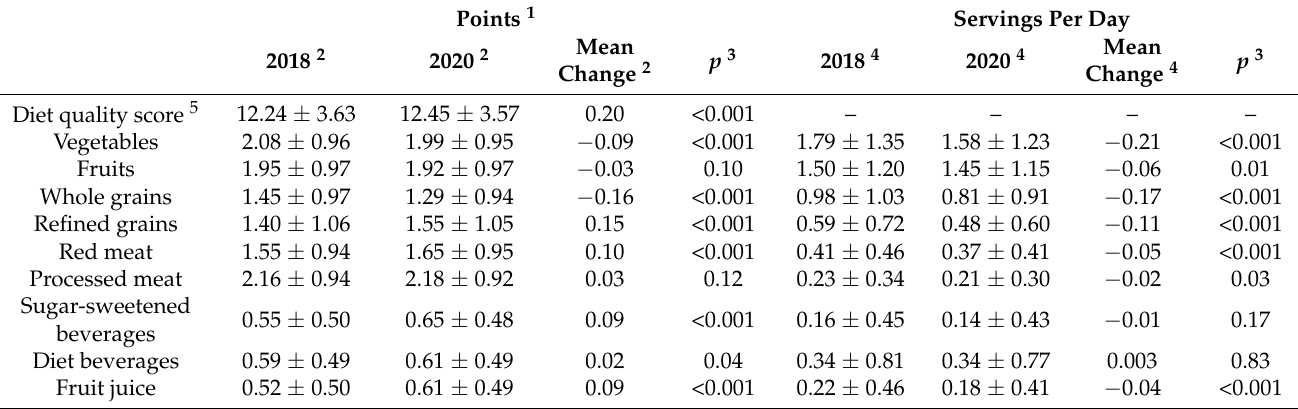
Table 2. Mean change in diet quality score (points) and individual food group consumption (points and servings per day) from before (2018) to during (July/Aug 2020) the COVID-19 pandemic among a subgroup of Cancer Prevention Study-3 cohort participants (N =